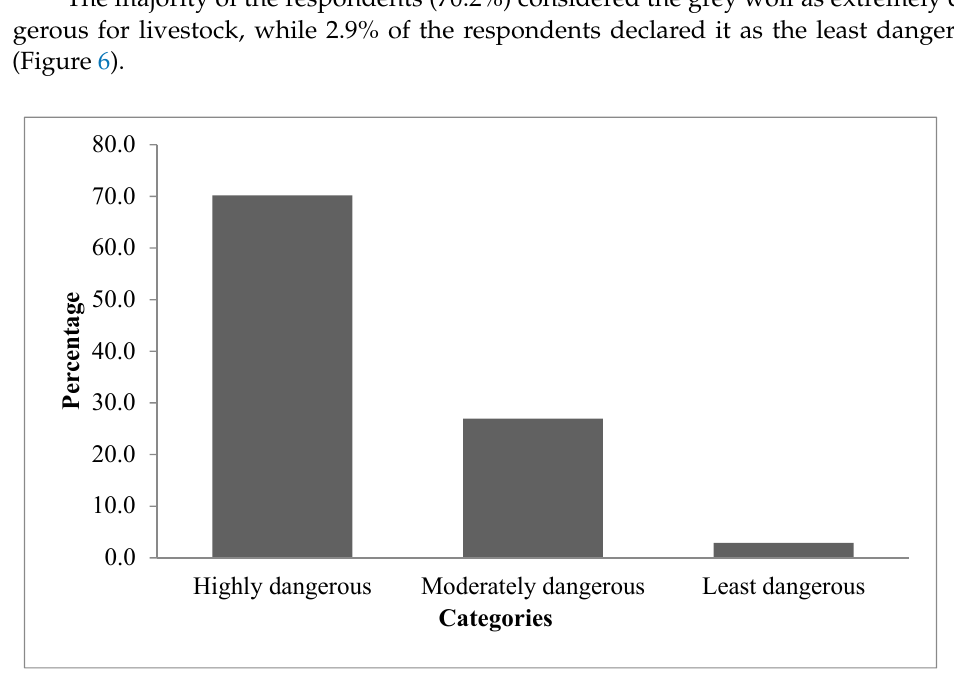
Figure 6. The danger of the grey wolf perceived by respondents in the study area.